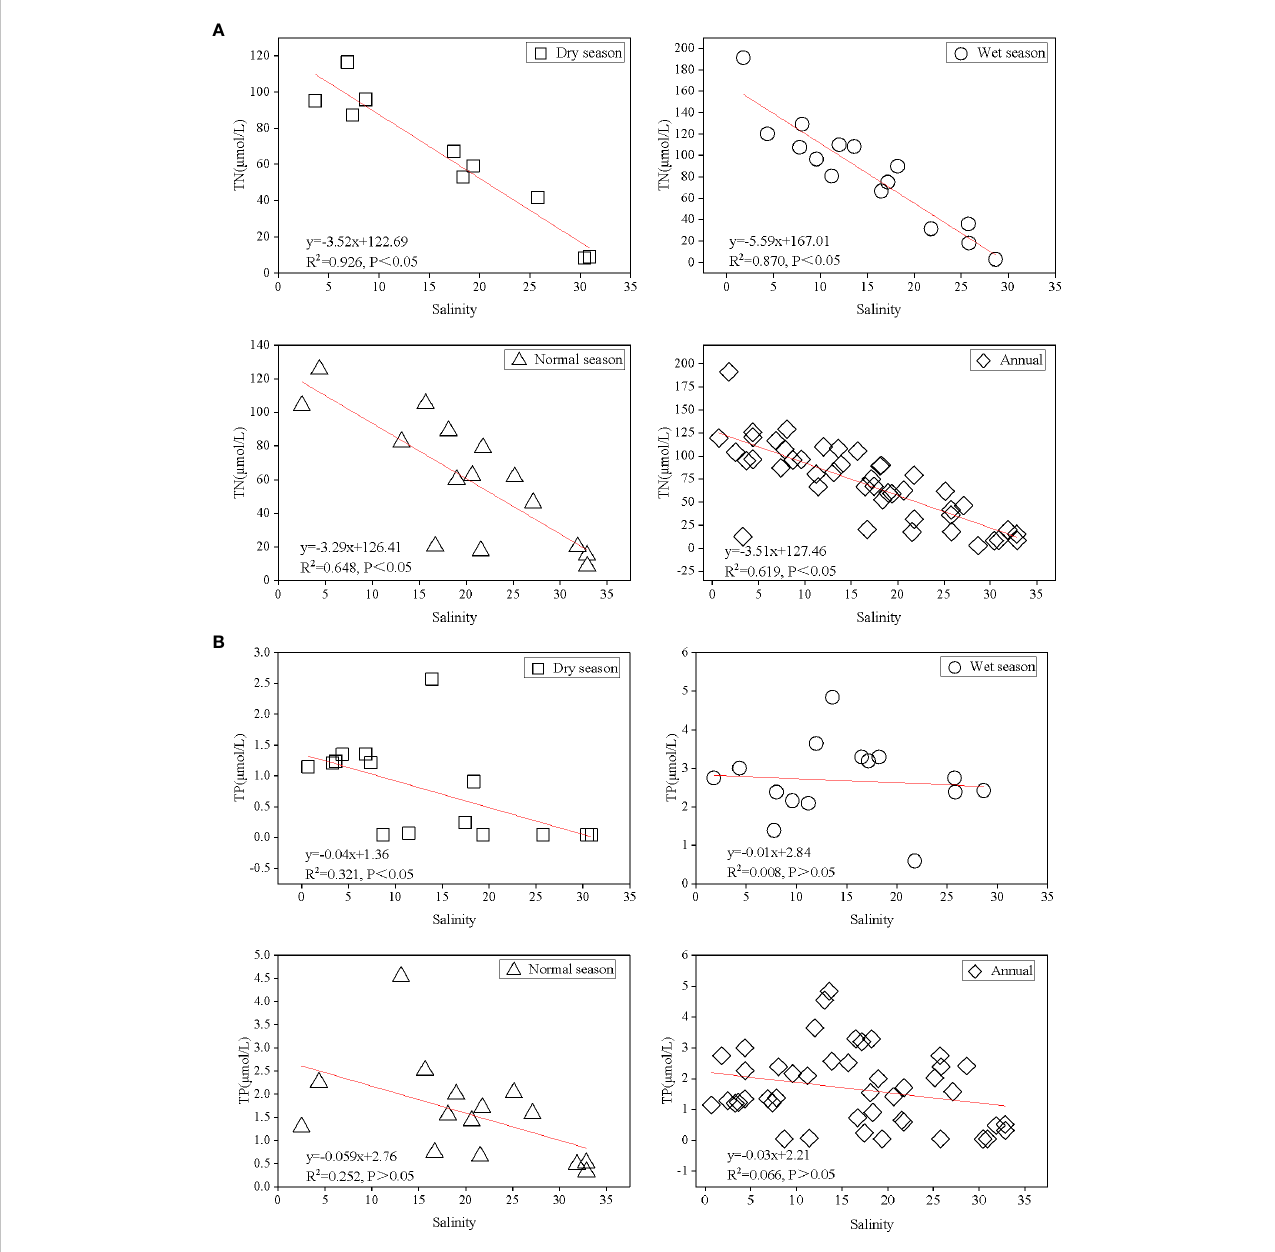
FIGURE 7 Linear regression analysis of TN (A) and TP (B) concentrations and salinity in the